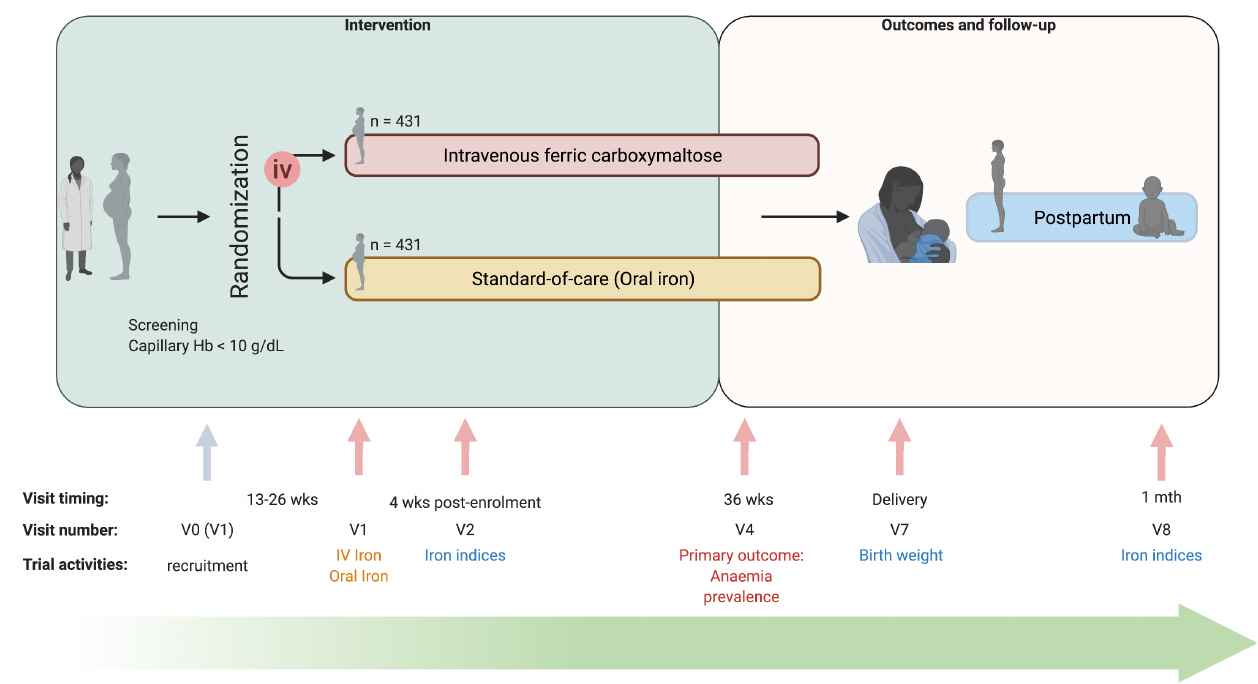
Figure 1. Study design and timeline of the Randomized controlled trial of the Effect of intraVenous iron on Anaemia in Malawian Pregnant women (REVAMP) (created with BioRender). V0 – visit 0; V1 – Visit 1; V2 – Visit 2; V4 – Visit 4; V7 – Visit 7; V8 – Visit 8; Abbreviations: iv – intravenous; wks – weeks. The study was designed as a two-arm trial (intravenous ferric carboxymaltose versus standard-of-care (oral iron)) where women were randomized in their second trimester of pregnancy. Study visits occurred over pregnancy, at birth, and follow-up to one-month postpartum. Women were scheduled to be visited in their home at 34 weeks’ gestation (Visit 3), and every two weeks from 38 weeks’ gestation until delivery (Visit 5 and 6) to measure capillary Hb, not included in the study design